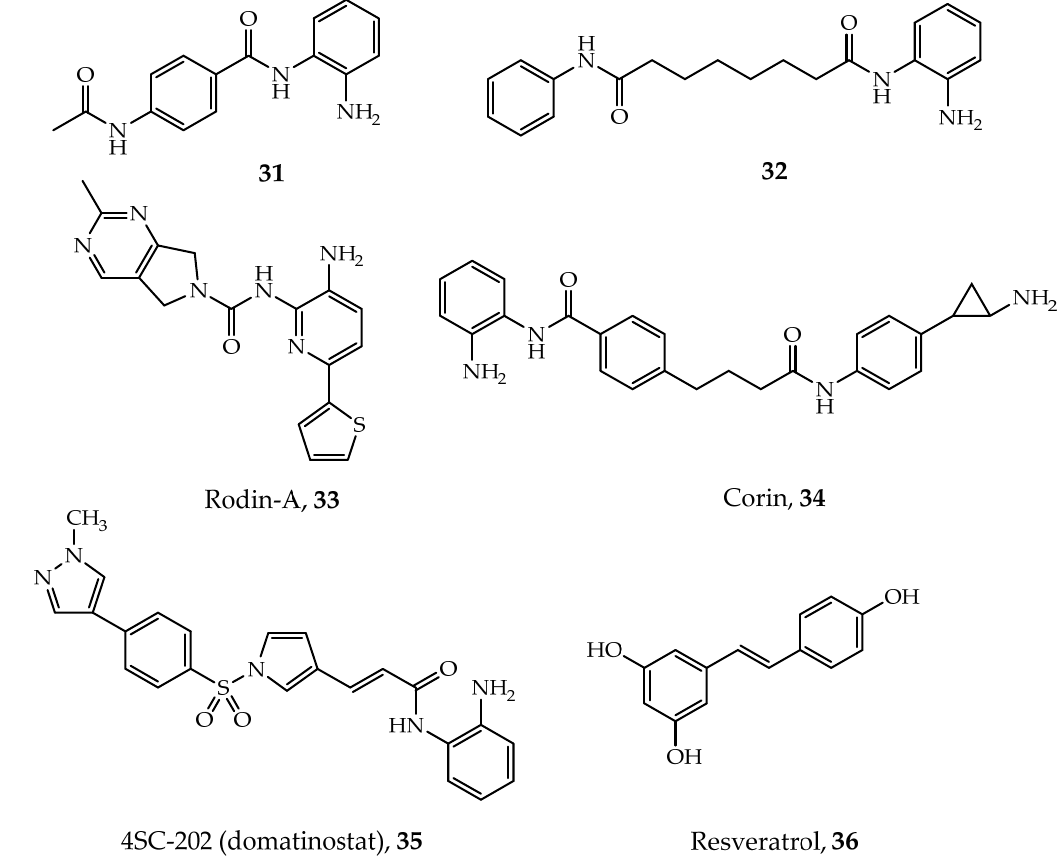
Figure 9. Specific-complex inhibitors.